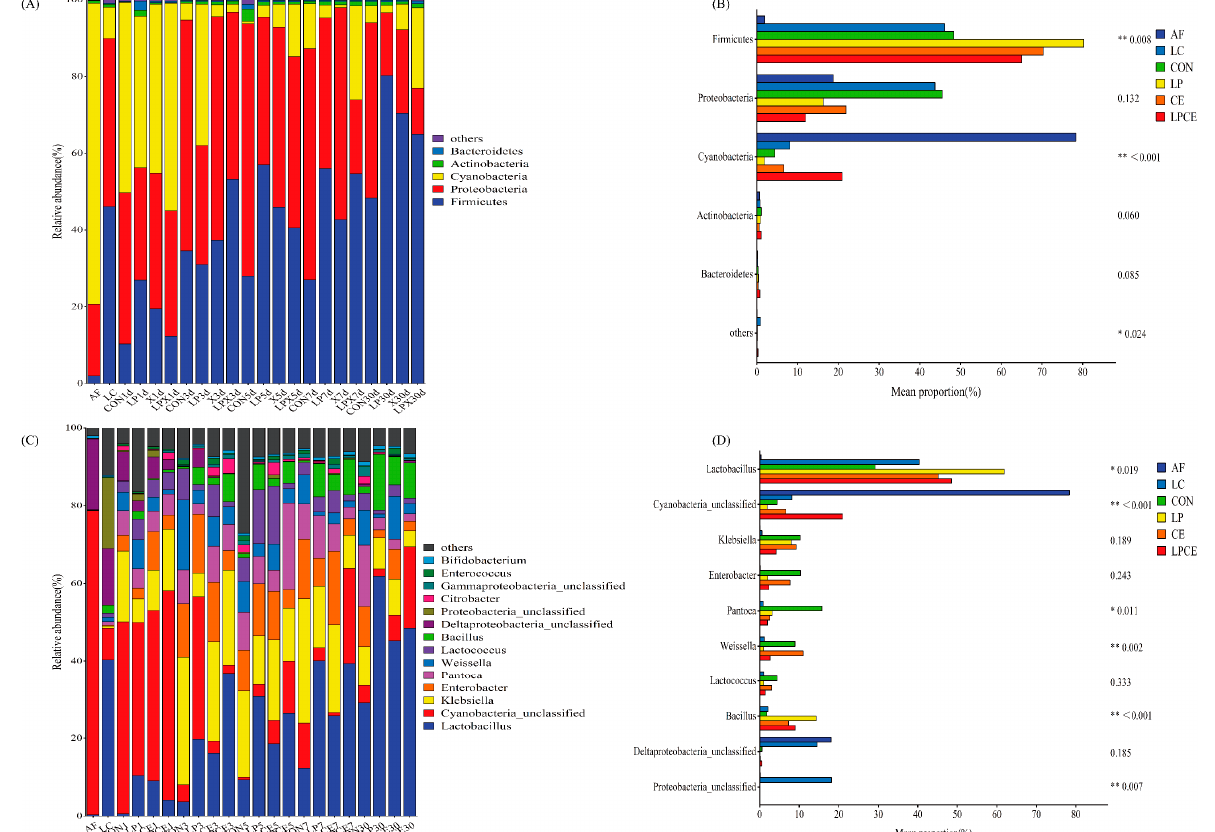
Figure 2. Bacterial community composition and succession in the mixed silage with or without additives. ( A ) bacterial community composition at the phylum level; ( B ) one-way analysis of variance bar plots at the phylum level among mixed groups after 30 days of silage; ( C ) bacterial community composition at the genera level; ( D ) one-way analysis of variance bar plots at the phylum level (ten most abundant genera) among the mixed groups after 30 days of silage. *, p < 0.05; **, p < 0.01; AF, fresh alfalfa; LC, Leymus chinensis ; CON, control silage, no additive; LP, silage containing Lactiplantibacillus plantarum ; CE, silage containing cellulase; LPCE, silage containing Lactiplantibacillus plantarum + cellulase.